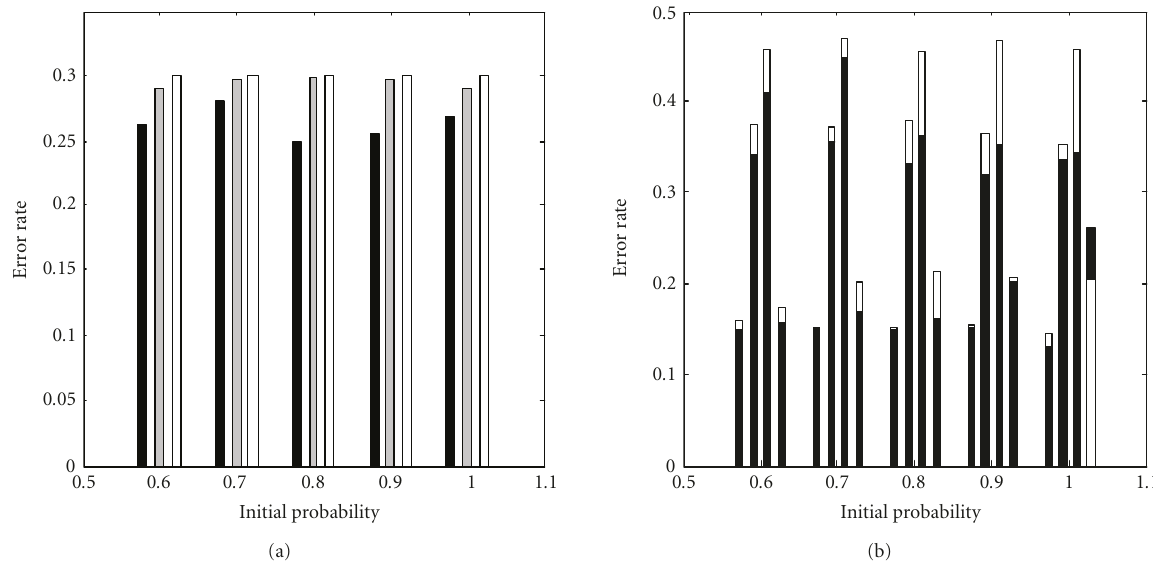
Figure 3: A comparison of the error rates (ERs) with di ff erent initial probabilities for subject CC. In the left, we compare the ERs averaged over targets with di ff erent initial probabilities in three conditions, the proposed method (black), the proposed method without updating initial probability (gray), and the baseline method (white). In the right, we compare ERs with and without updating initial probability in detail. There are five groups of error bars, and each group contains the error bars of the four targets (targets 1 to 4, from left to right). In each group, the bars with white top indicate that ER is reduced after update, and the length of the white part denotes that the amount of ER has been reduced. Similarly, the bars with black top indicate that ER is increased after update. The bars which are all black indicate that ER is unchanged after update.